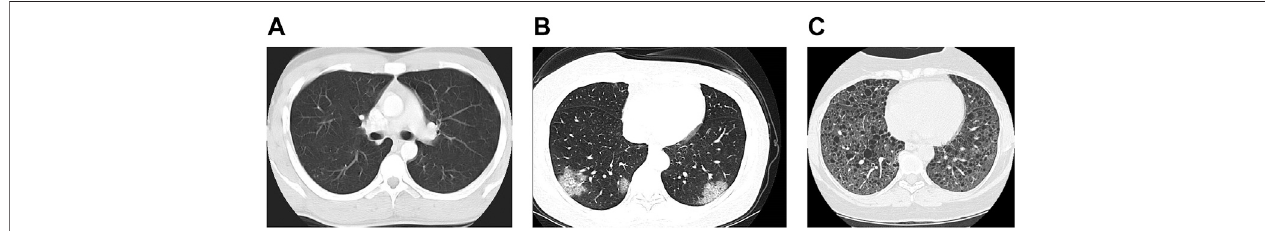
FIGURE 2 | CT chest images: (A) normal, (B) COVID-19 pneumonia, and (C) common pneumonia.